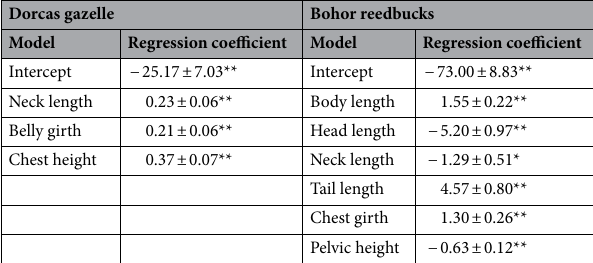
Dorcas gazelle Bohor reedbucks